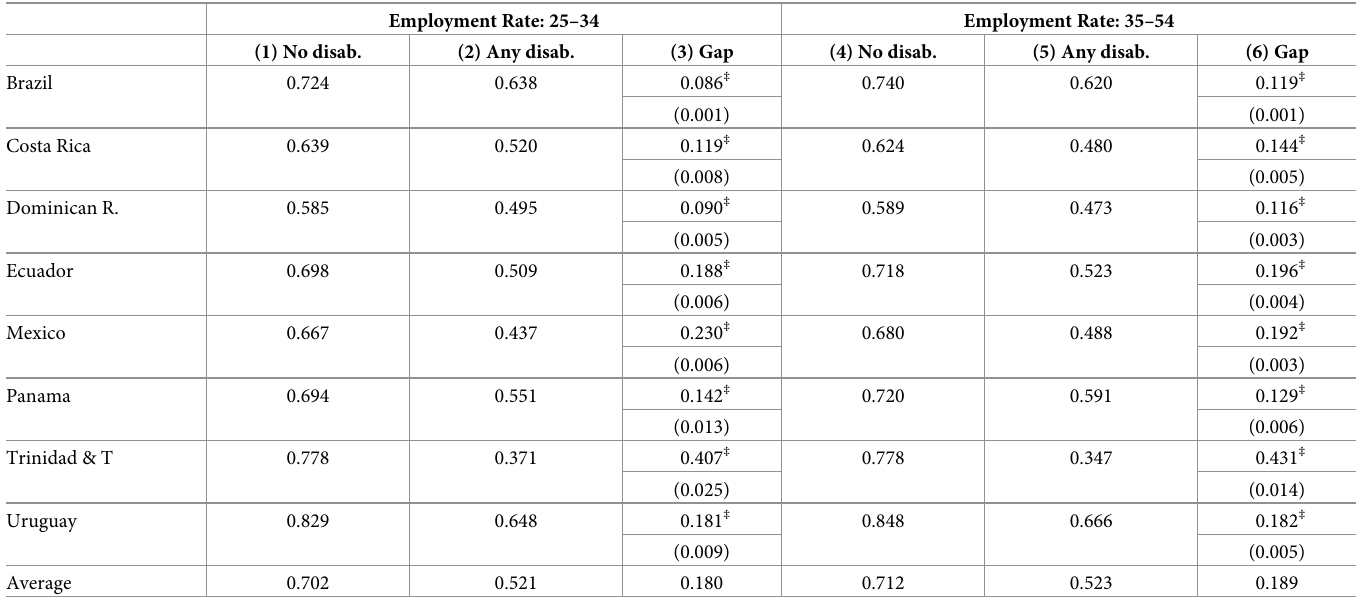
Table 5. Estimates for employment rates and disability